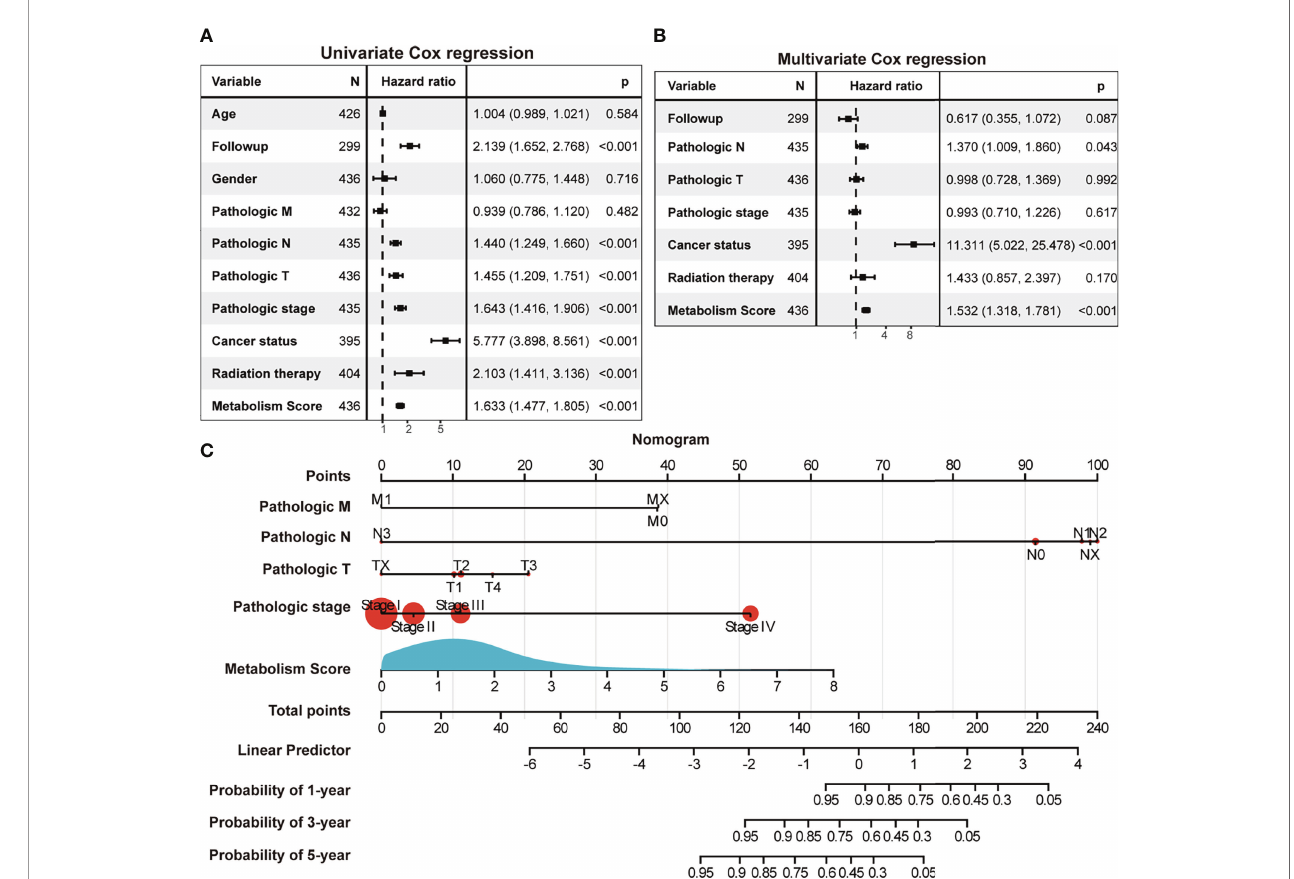
FIGURE 6 | The Metabolism Score based on a metabolic prognostic model possibly acted as an independent risk factor in LUAD. (A) Univariate Cox regression analysis of risk factors in LUAD. (B) Multivariate Cox regression analysis of risk factors in LUAD. (C) Assessment nomogram with Metabolism Score to evaluate prognosis of LUAD (1-, 3- and 5-year survival